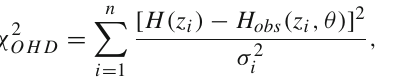
Table 1 The best-fit results of model parameters and free normalization parameter M obtained from the analysis with different combinations of the data sets